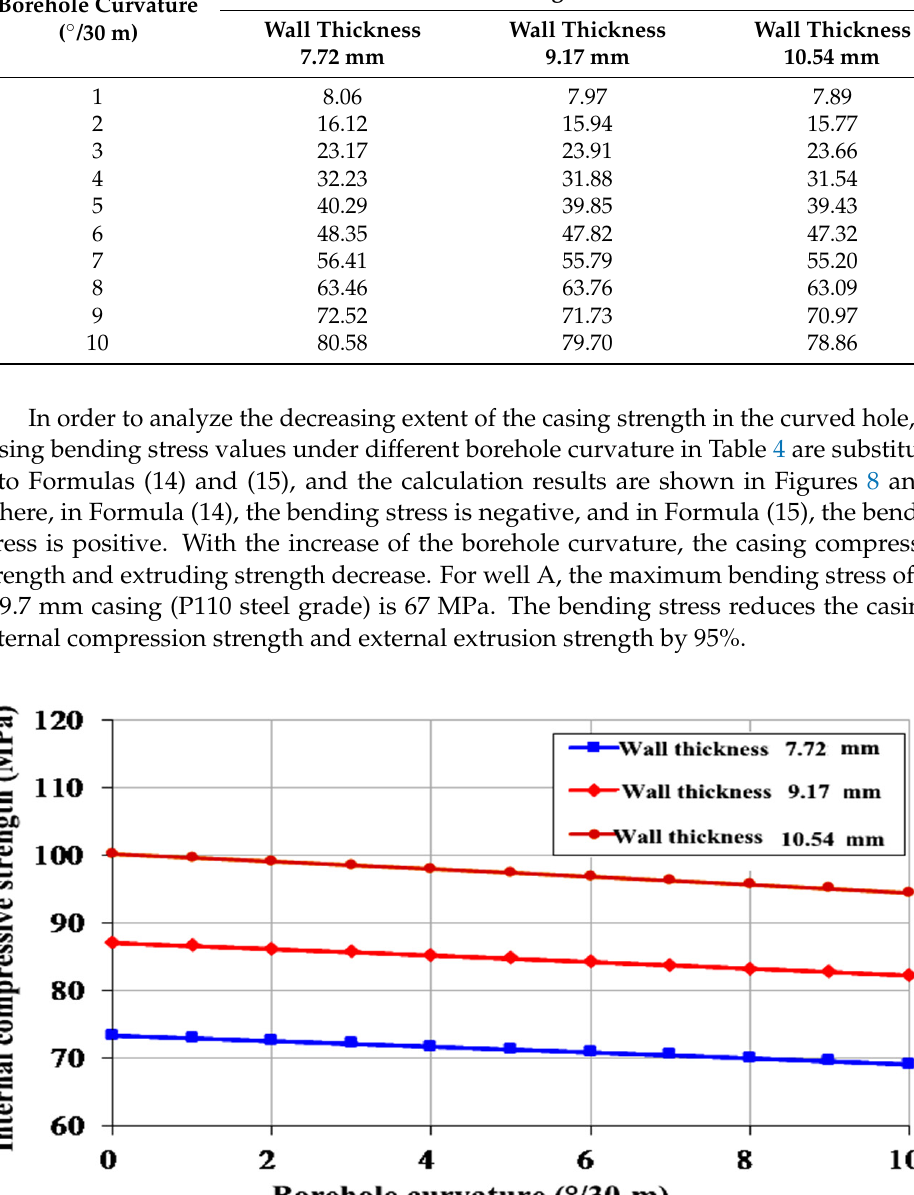
Table 4. Casing bending stress under different borehole curvature.